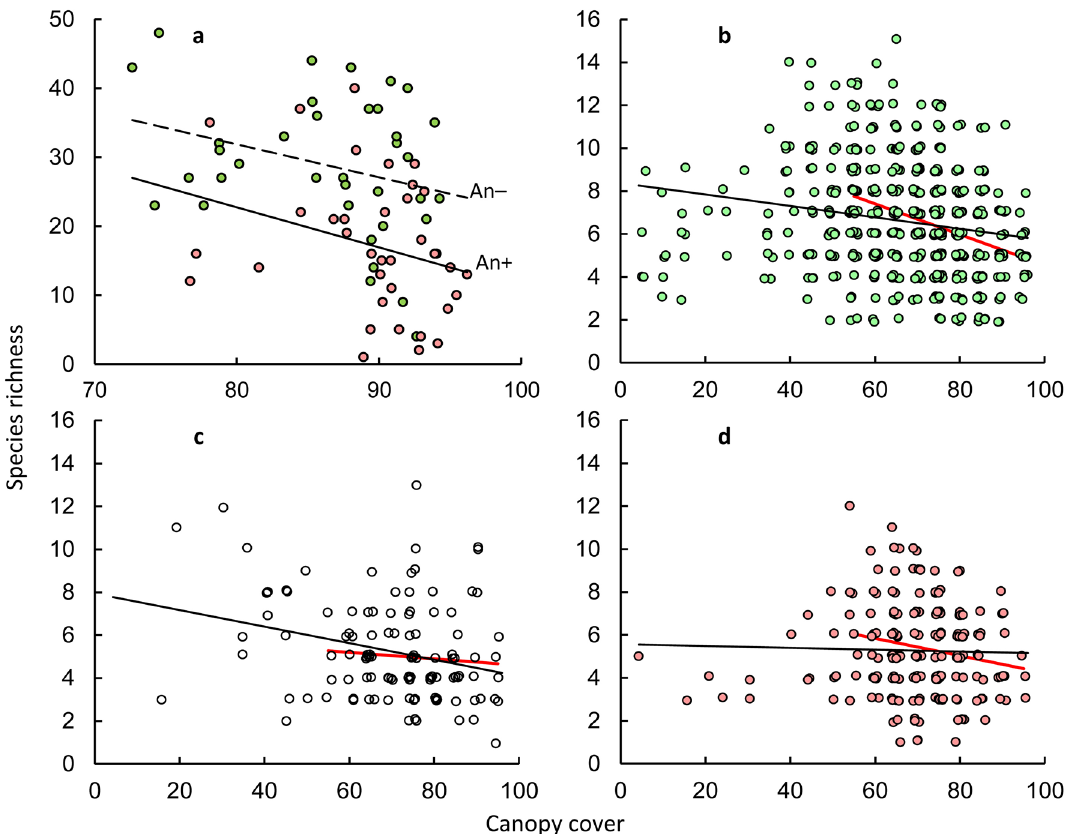
Figure 8. Relationship between the average canopy cover and the number of ground cover species per 400 m 2 (inter-habitat comparison) ( a ) and per 1 m 2 (intra-habitat comparison) at plots dominated by native tree species (green circles) ( b ), alien tree species, excluding Acer negundo (white circles) ( c ), and individually— Acer negundo (pink circles) ( d ). The points are slightly jittered to avoid overlapping on Figures b–d. The approximations in the range of 55–95% canopy cover in Figures b–d are shown with red